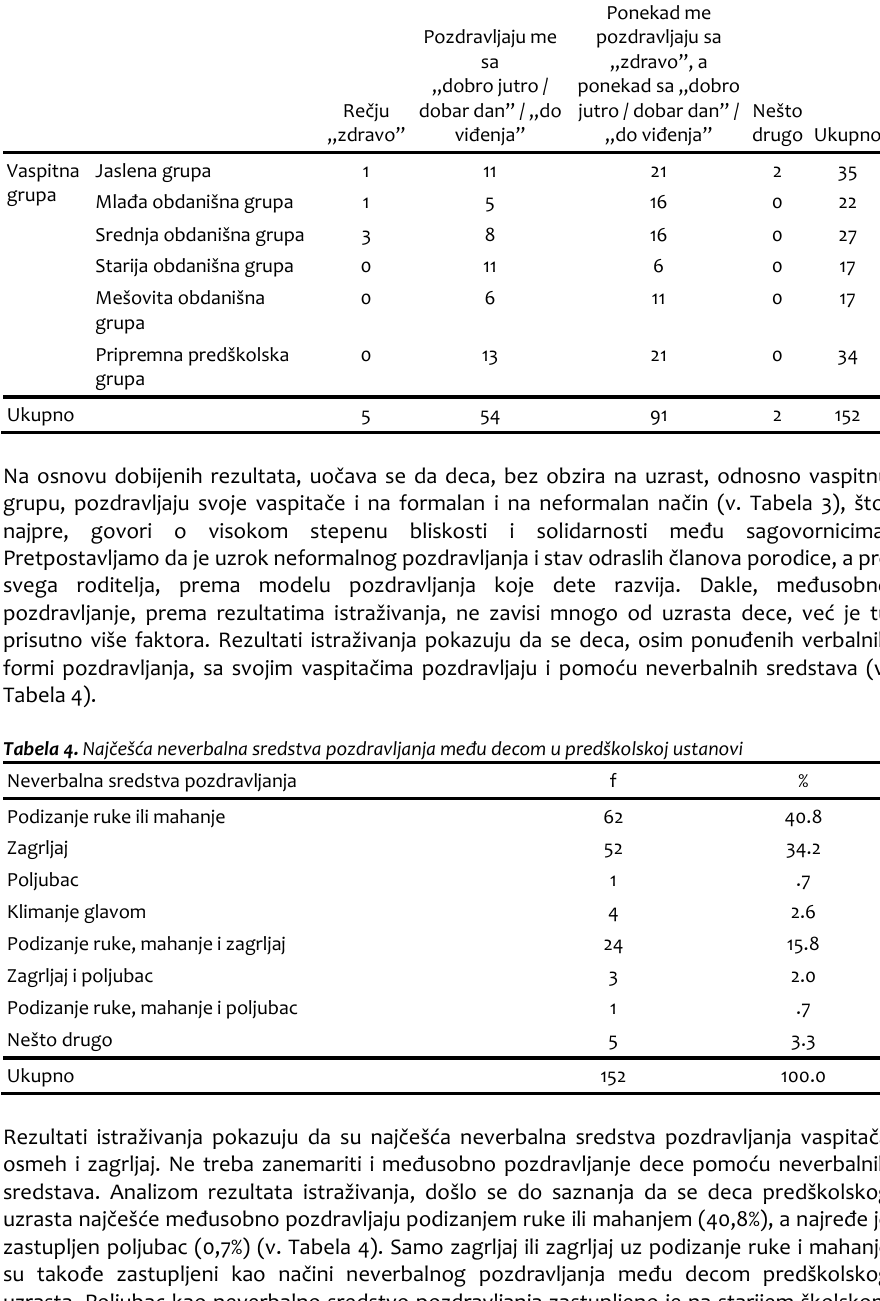
Tabela 3. Načini pozdravljanja vaspitača u predškolskim ustanovama u zavisnosti od vaspitne grupe